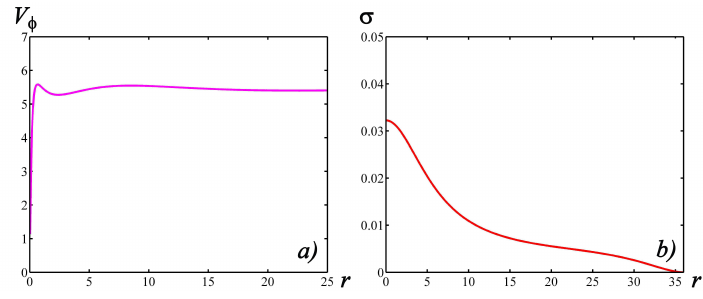
Fig. 2. (a) Model rotation curve. (b) Initial surface density distribution σ ( r ). (1500; 360). The computational domain size is R max = 3 R opt = 36 kpc and the units used are 1 kpc for distance and 40 km s − 1 for